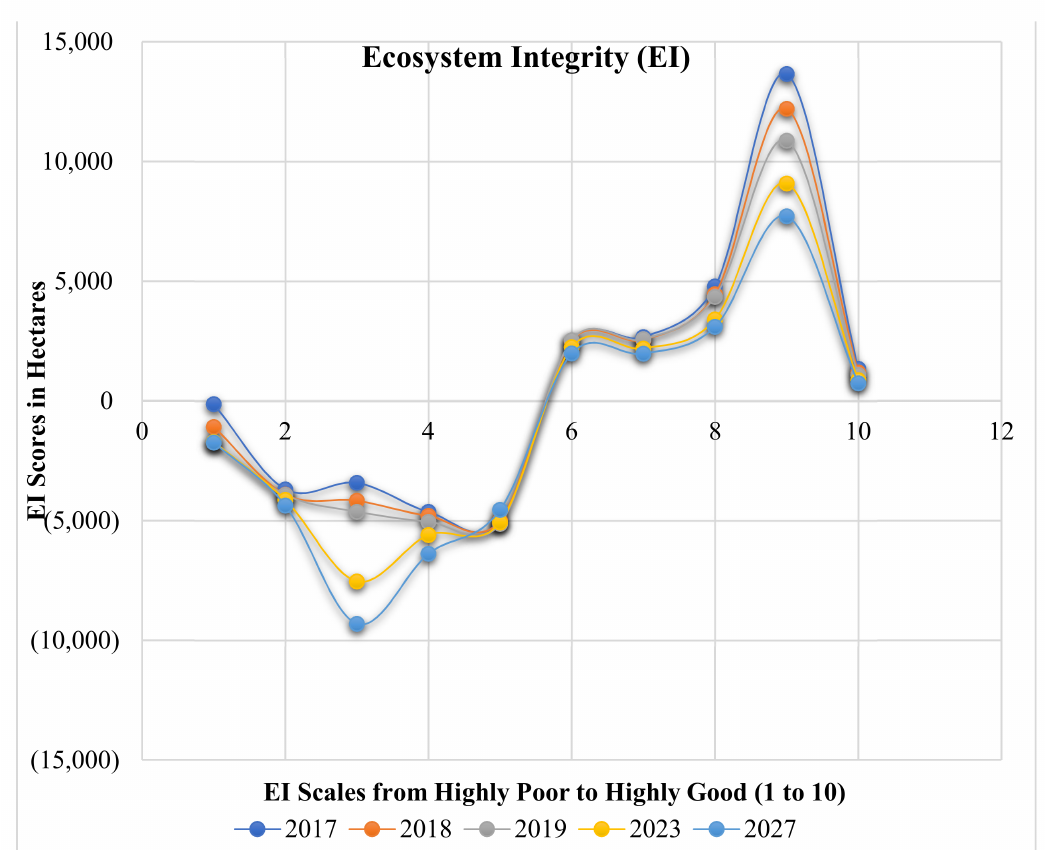
Figure 8. Ecosystem integrity based on the time series and predicted ecosystem functions (e.g., vegetation condition).